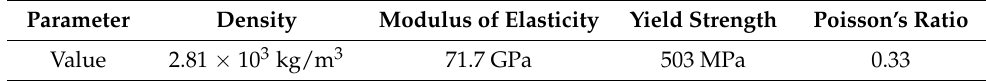
Table 3. The material parameters of